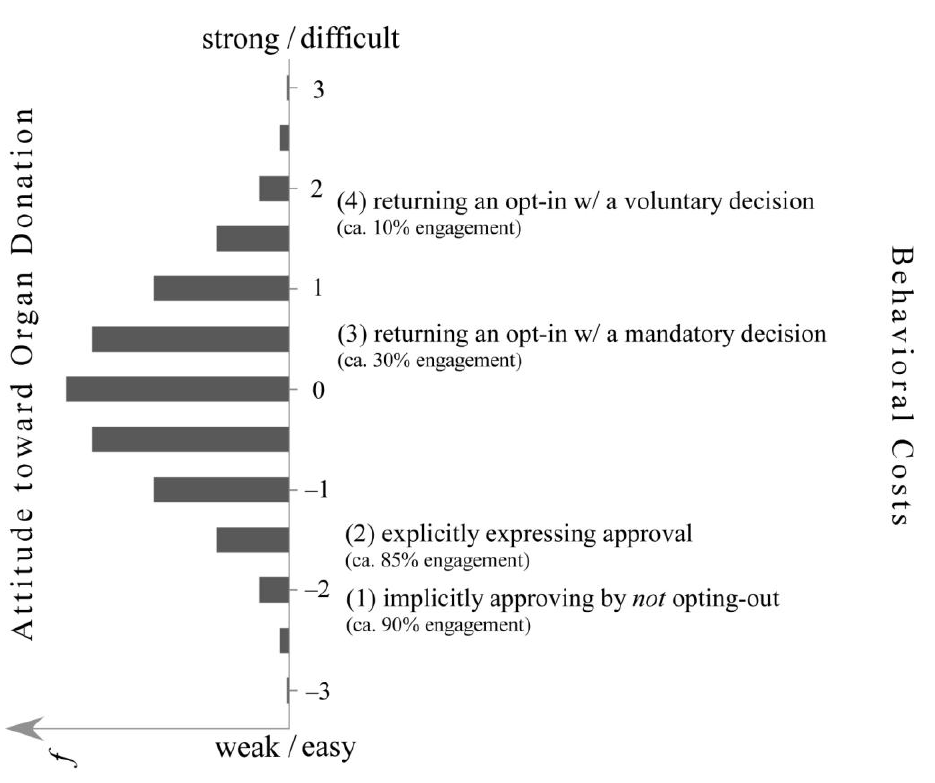
Figure 1. Offsetting specific behavioral costs with the strength of a person’s individual attitude toward organ donation . The horizontal bars display a prototypical distribution of the strength of people’s attitudes toward organ donation on a scale ranging from weak to strong. Correspondingly, organ-donation-relevant behaviors are ordered according to their cost-based difficulty on a scale ranging from easy to